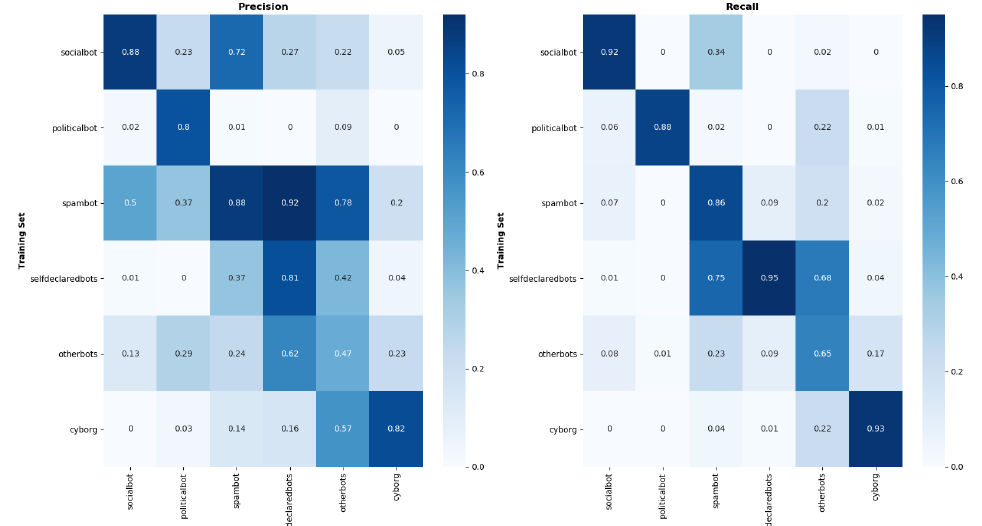
Figure 3. Precision and Recall of binary human or i bot type classifiers, trained on the D i dataset and tested on other bot types. The low cross-type performance showcases the need of defining different bot